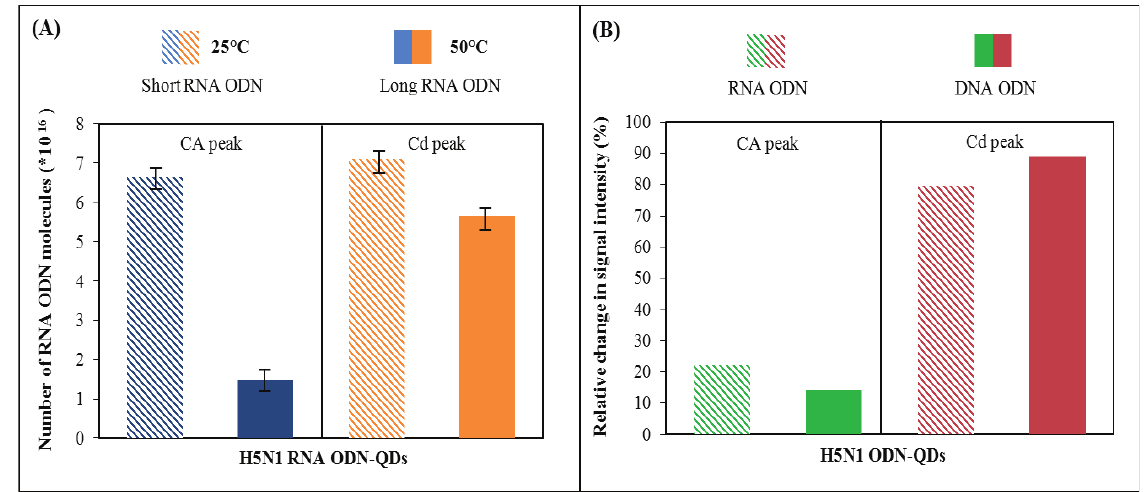
Figure 7. ( A ) The effect of the RNA-ODN length on the number of hybridized molecules. Two long varieties of China RNA ODN sequences were tested due to CA and Cd peak detection. Short RNA ODN sequence was hybridized at 25 °C and long RNA ODN sequence was hybridized at 50 °C; ( B ) Percentage of signal intensity of the long ODN sequence related to the short ODN sequence detected due to CA and Cd peak for RNA and DNA ODN